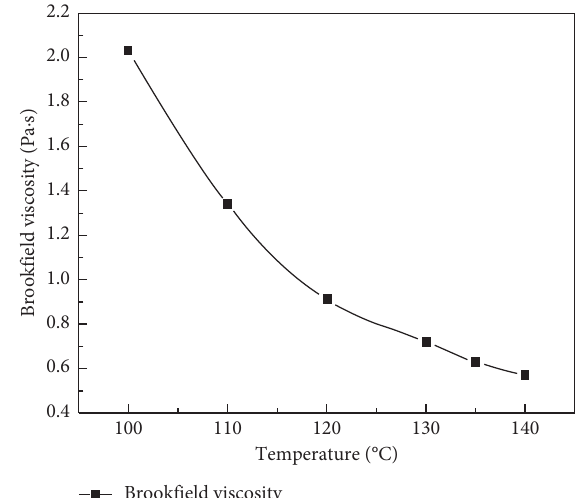
Figure 4: WBA’s Brookfield viscosity test at different temperatures ( ° C).